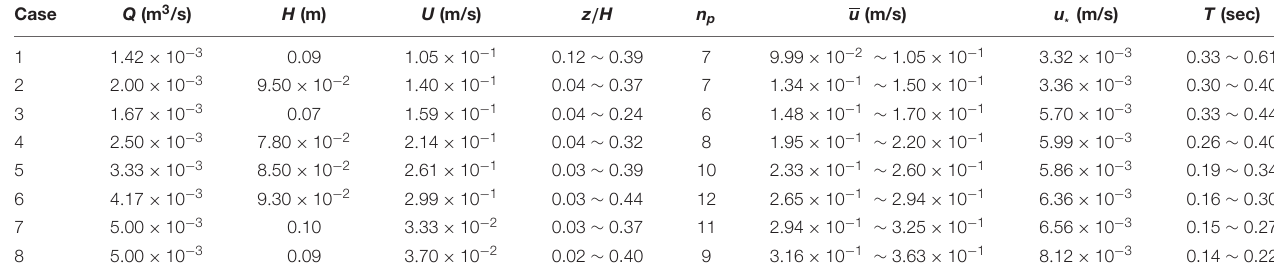
TABLE 2 | Experimental